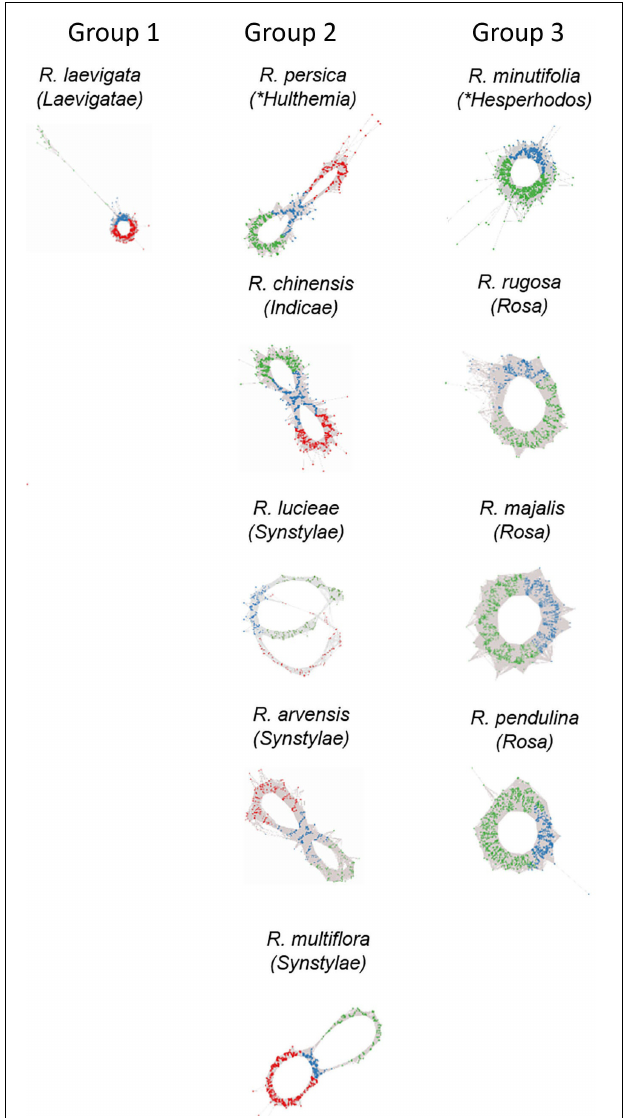
FIGURE 3 | Genomic analysis of 5S rDNA variants in diploid (2n = 2x = 14) species of Rosa . Projections of 5S rDNA cluster graphs: Loops represent IGS reads colored according to the 5S_A (green) and 5S_B (red) IGS variants; genic regions are in blue. Group 1 represents species with dominance of 5S_B variant; Group 2 contains diploids with balanced ratio of both variants; and Group 3 shows species with only A variant in the genome. Name of the sections within subg. Rosa is given in brackets; other subgenera are marked by asterisks.